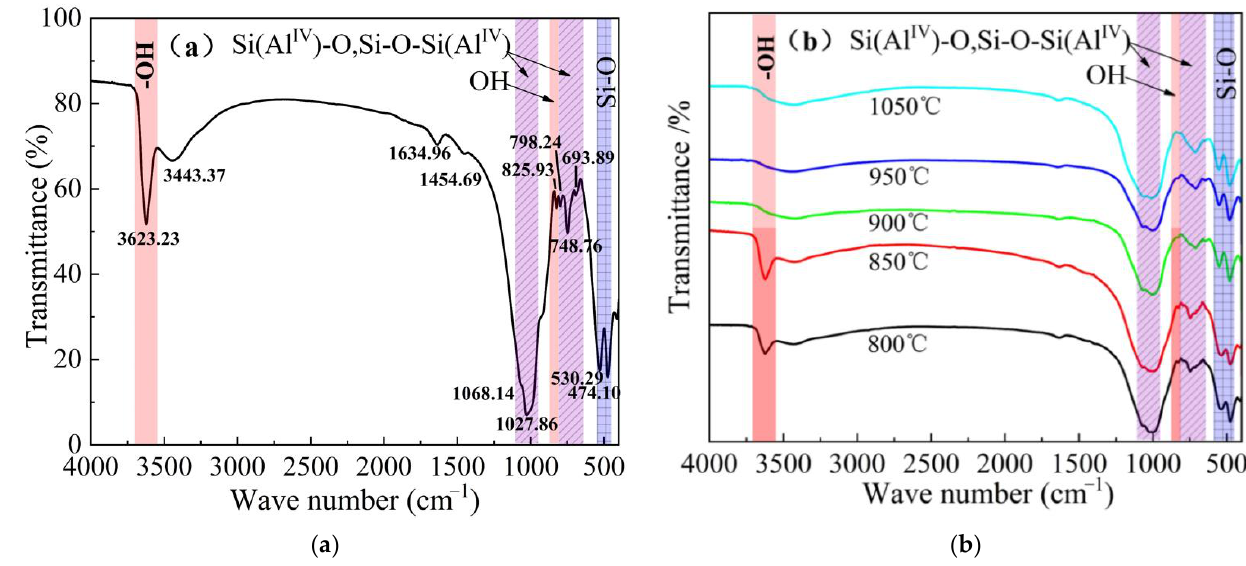
Figure 5. FTIR spectra of raw ore ( a ) and roasted products ( b ).